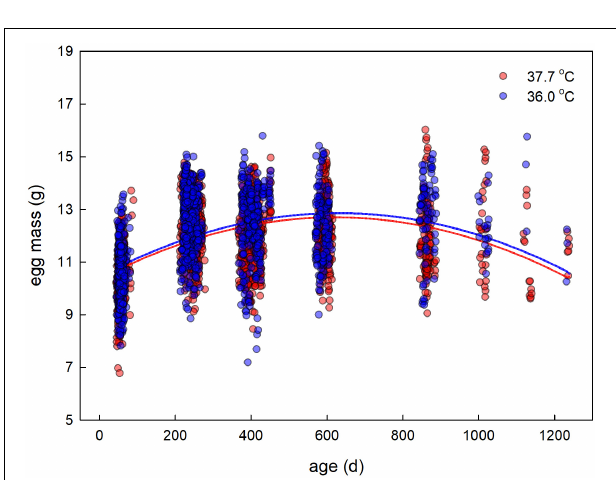
FIGURE 3 | Egg laying rate plotted against age for female Japanese quail incubated at 37.7 ◦ C ( n = 99 females) or 36.0 ◦ C ( n = 80 females). Data points and error bars represent averages ( ± SE) based on the raw data. The lines represent the model predictions (see Table 4 ) for each incubation temperature, and several ages of last sampling, to illustrate the selective mortality of poor layers.